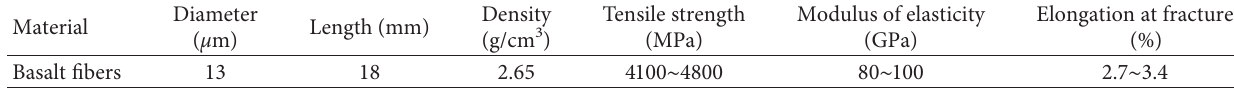
Table 1: Physical and mechanical properties of basalt